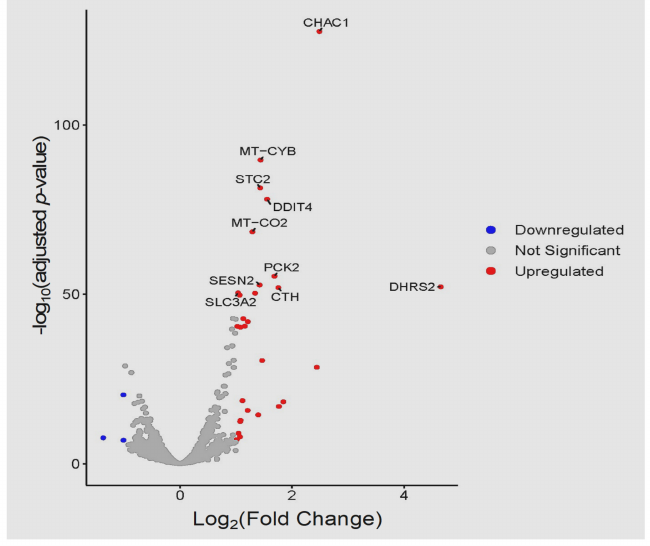
Figure 11. Volcano plot comparing the top 10 DEGs, with the highest differences in expression, between infected and control samples at 24 hpi. Upregulated (red) and downregulated (blue) genes are shown. p -values were plotted on the y -axis while log 2 FC values are plotted on the x -axis. Each dot in the plot represents one